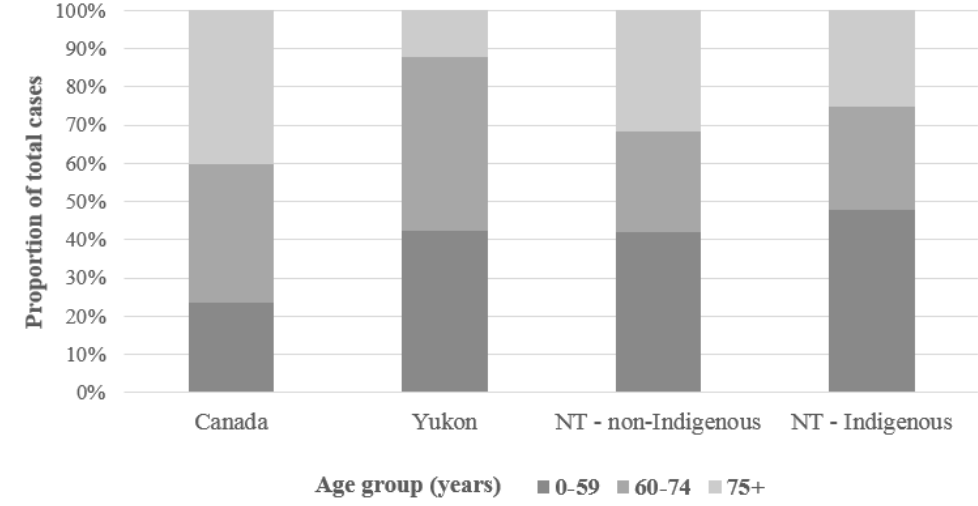
Figure 1. Age distribution of total gastric cancer cases by population; northern territories, Canada; various years. Canada and Yukon include cases diagnosed 2003–2012; Northwest Territories (NT) includes cases diagnosed 1997–2015.